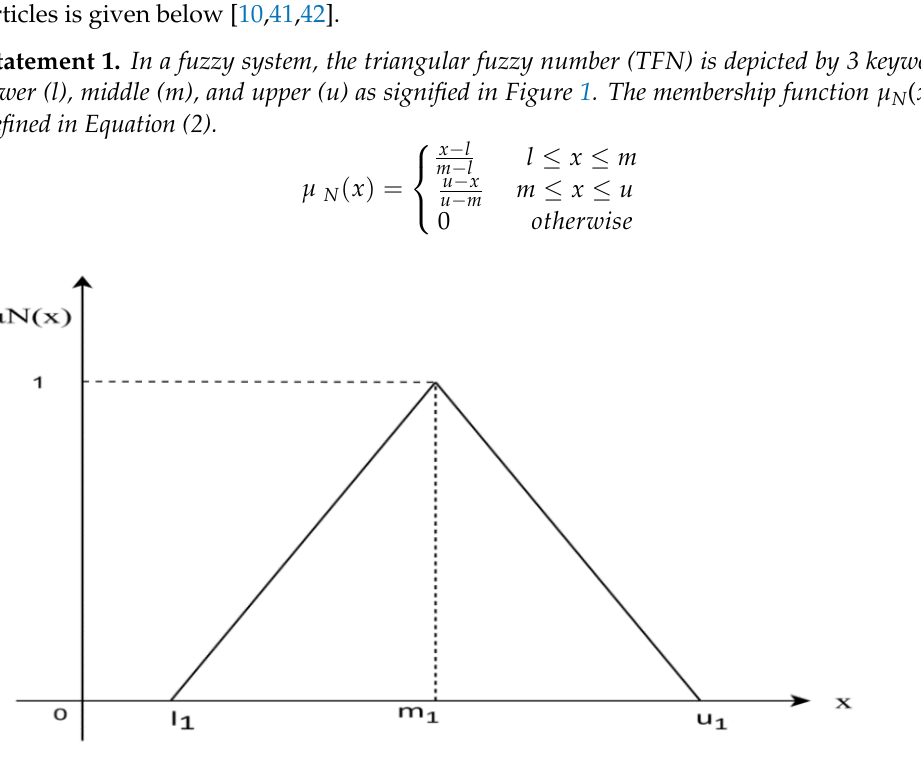
Figure 1. Triangular fuzzy numbers.